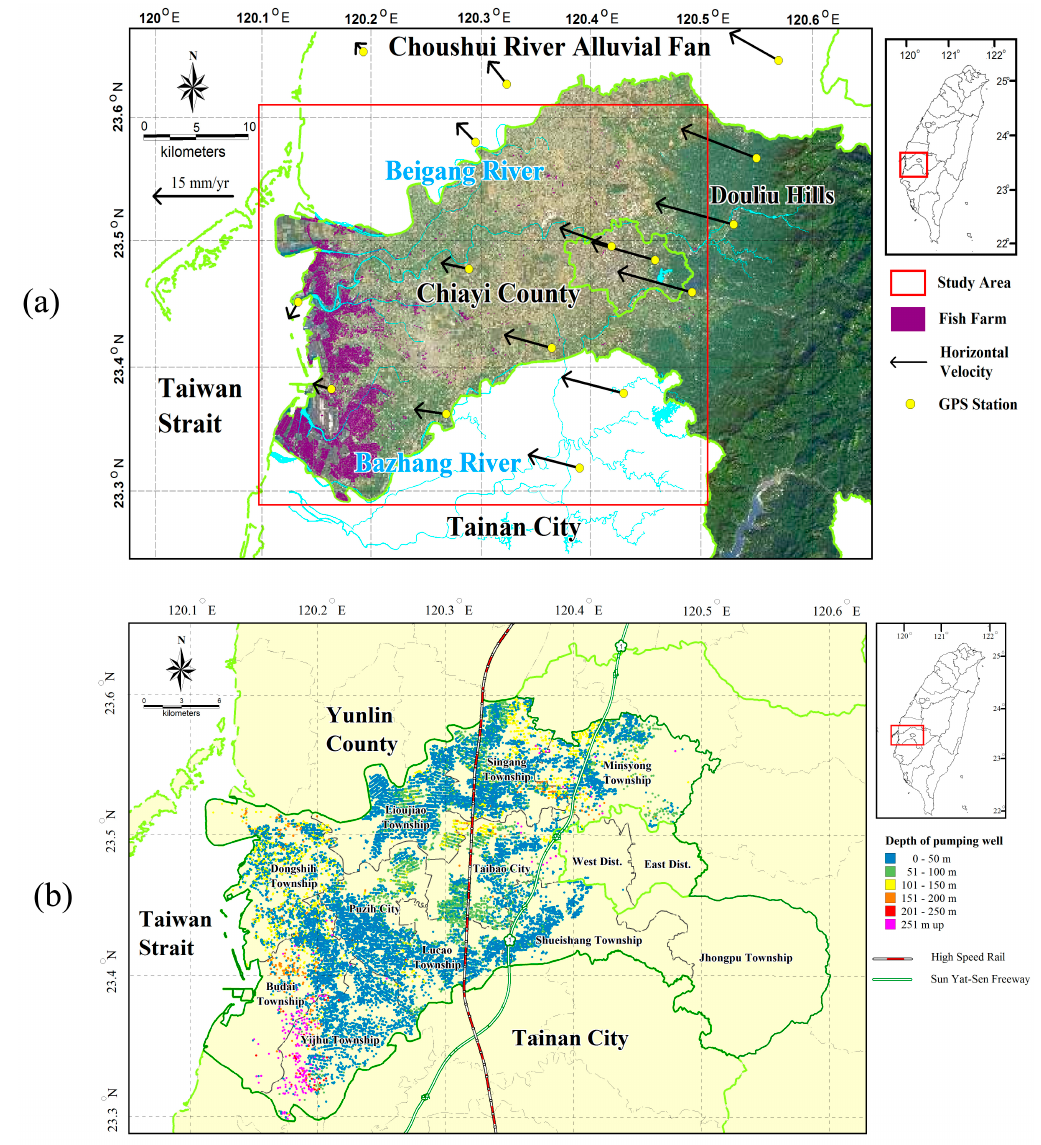
Figure 1. ( a ) Geographic information (limited) about Chiayi County, Taiwan, with fish ponds, horizontal velocities from GPS, and Tropic of Cancer at 23.5°N; ( b ) Distribution of groundwater pumping wells at different depths.